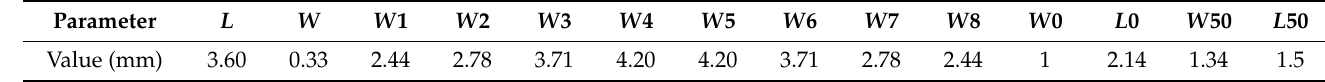
Table 1. Geometrical parameters of the CGF SAA.